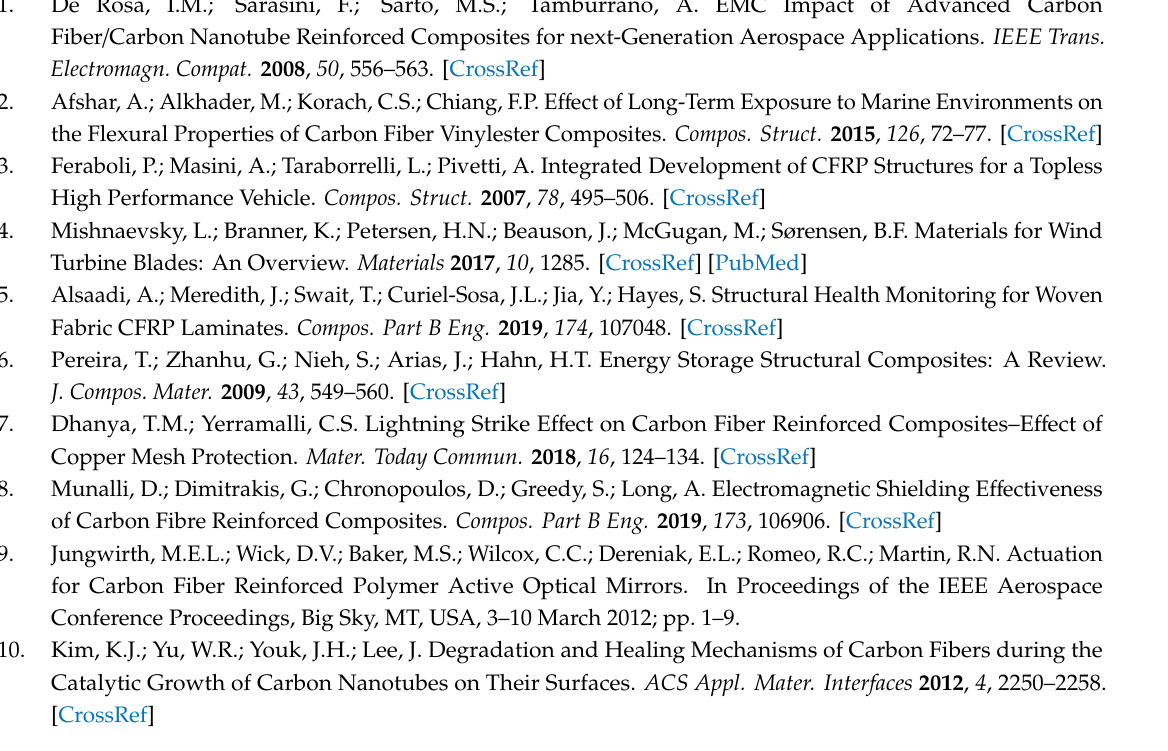
Figure S1 PCF sample irradiated at 2.5 W (25 J / cm − 2 ); Figure S2: PCF sample irradiated at 3.75 W (37 J / cm − 2 ); Figure S3. PCF sample irradiated at 4 W (39 J / cm − 2 ); Figure S4. PCF sample irradiated at 4.25 W (42 J / cm − 2 ); Figure S5. PCF sample irradiated at 4.5 W (44 J / cm − 2 ); Figure S6. PCF sample irradiated at 4.75 W (47 J / cm − 2 ); Figure S7. PCF sample irradiated at 5 W (49 J / cm − 2 ); Figure S8. Area of the irradiation for TCF representative samples. (a) TCF4.75 W (47 J / cm − 2 ), (b) TCF7.5 W (74 J / cm − 2 ), (c) TCF10 W (99 J / cm − 2 ); Figure S9. bTCF sample.; Figure S10. TCF sample irradiated at 3.75 W (37 J / cm − 2 ); Figure S11. TCF sample irradiated at 4.25 W (42 J / cm − 2 ); Figure S12. TCF sample irradiated at 4.75 W (47 J / cm − 2 ); Figure S13. TCF sample irradiated at 7.5 W (74 J / cm − 2 ); Figure S14. TCF sample irradiated at 10 W (99 J / cm − 2 ); Figure S15. bPCF sample; Figure S16. PCF sample irradiated at 4.25 W (42 J / cm − 2 ), Figure S17. Raman spectra of PCF sample irradiated at various